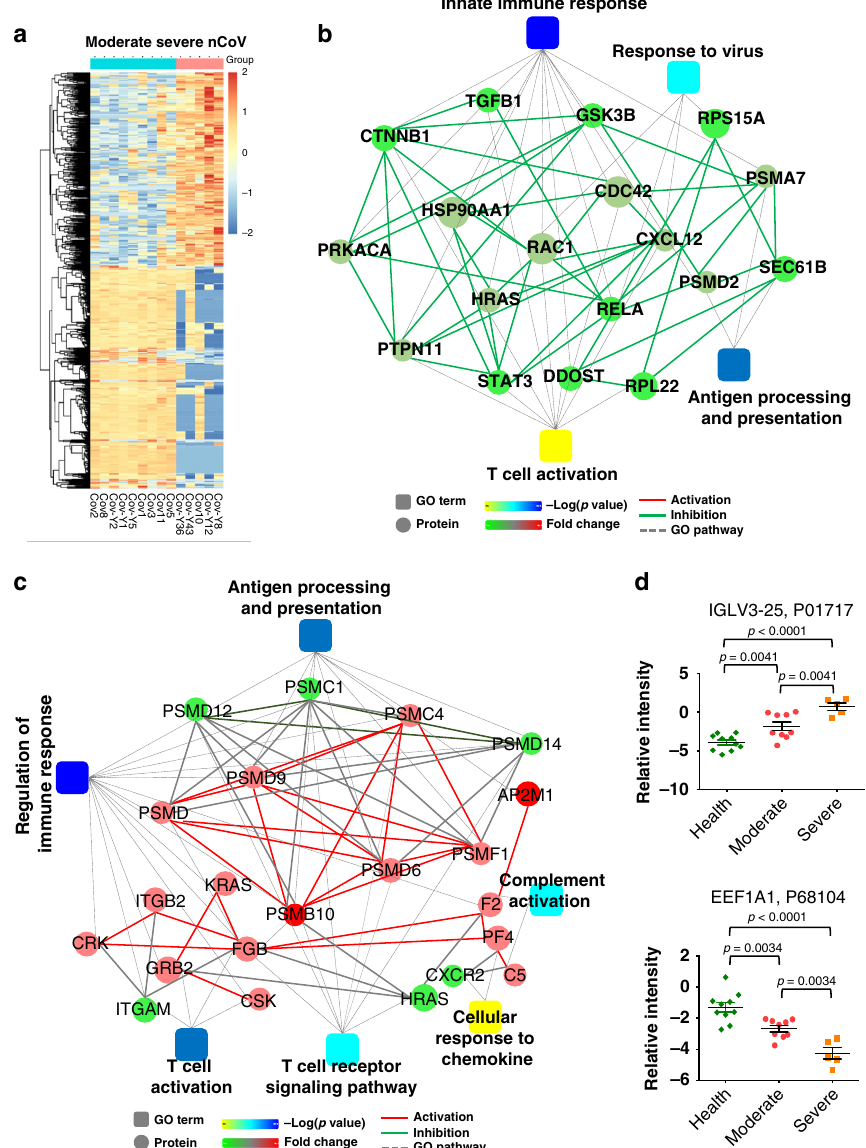
Fig. 3 Immune system response in moderate and severe COVID-19 patients. a Heatmap depicting the levels of differentially identi fi ed proteins in patients with moderate and severe COVID-19. The graphs show the relative intensity of differentially expressed proteins. Proteins included in the heatmap meet the requirement that fold change >2 or <0.5 and p value ( t test) of <0.05 comparing severe to moderate patient samples. Color bar represents the relative intensity of identi fi ed proteins from − 2 to 2. b The interaction diagram of proteins involved in the innate immune response, response to the virus, antigen processing and presentation, and T cell activation. Network nodes and edges represent proteins and protein – protein associations. Green solid lines represent inhibition; gray dotted lines represent GO pathways. Color bar from red to green represents the fold change of protein level from increasing to decreasing. The signi fi cance of the pathways represented by − log( p value) (Fisher ’ s exact test) was shown by color scales with dark blue as most signi fi cant. c The interaction diagram of proteins involving in antigen processing and presentation, complement activation, cellular response to chemokine, regulation of immune response, T cell activation, and T cell receptor signaling pathway. Green solid lines represent inhibition; red solid lines represent activation; gray dotted lines represent GO pathways. Color bar from red to green represents the fold change of protein level from increasing to decreasing. The signi fi cance of the pathways represented by − log( p value) (Fisher ’ s exact test) was shown by color scales with dark blue as most signi fi cant. d The scatter plot graphs showing two proteins that are potential diagnostic markers for severe COVID-19. One-way ANOVA was used to analyze the data. For Health group, n = 10; for nCoV Moderate group, n = 9; for nCoV Severe group, n = 5. Data are presented as mean ± SEM. Source data are provided as a Source Data fi